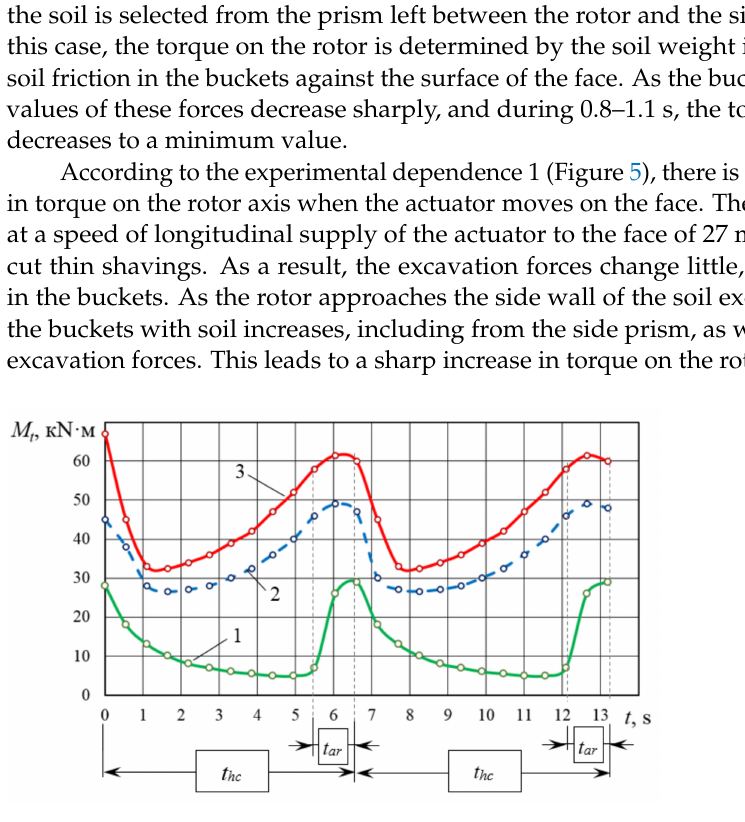
Figure 5. The torque change on the rotor during the cycle with the additional rotation of the intermediate frame t ar = 1.1 s: 1 − V s = 27 m/h, V c = 6 m/s; 2 − V s = 104 m/h, V c = 9 m/s; 3 − V s = 104 m/h, V c = 6